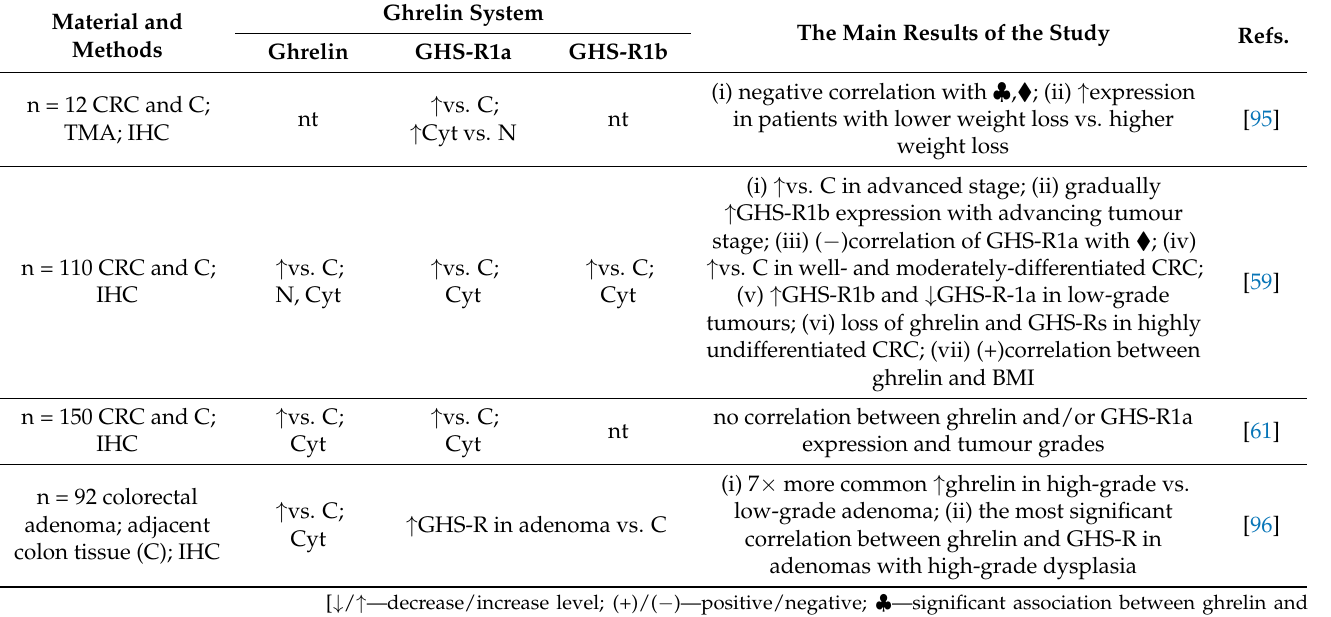
Table 2. Tissue Expression of Ghrelin System Components in CRC and Colorectal Adenoma.